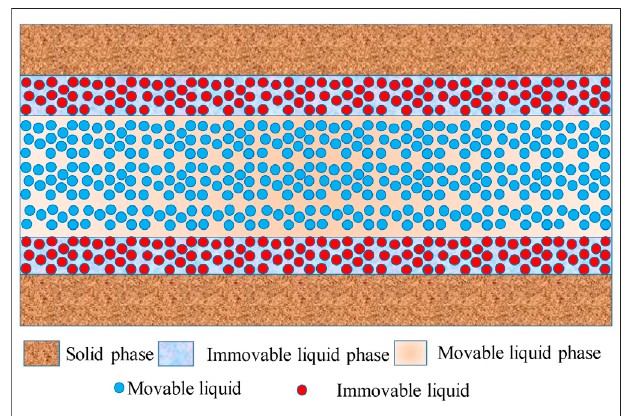
FIGURE1| Schematic diagramofthepresence ofBLEat